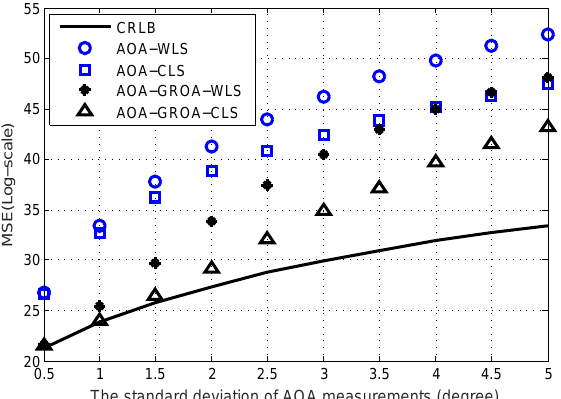
Figure 3. Average MSE results of AOA-only WLS, AOA-only CLS, AOA-GROA WLS and AOA-GROA CLS methods, σ AOA varies, whereas σ GROA = 3 × 10 − 3 and σ s = 10 − 2 m.